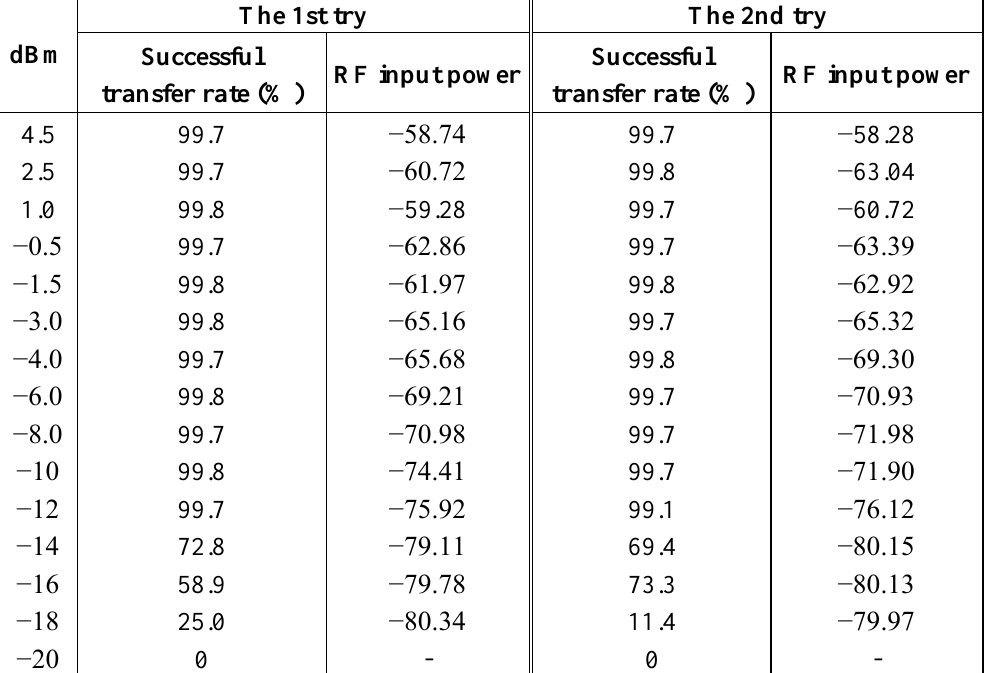
Table 1. Successful Packet Transfer Rate according to the Stationary Node dBm (distance: 25 m).